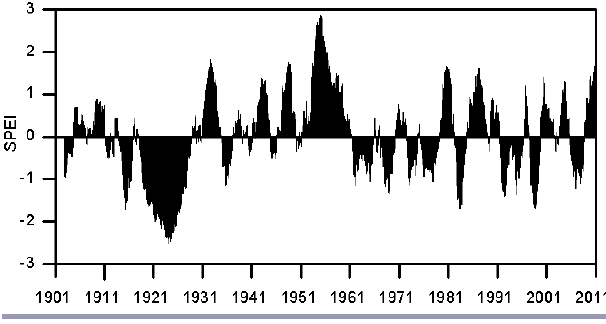
Fig. 3 . SPEI index (standardized precipitation evapotranspiration index), a multiscalar drought index, for a 24-month period, from 1901 to 2011 in the Bungku region. Categorization of dryness by SPEI: Near normal (-1 to 1); Moderate dryness (-1.49 to -1); Severe dryness (-1.99 to -1.5); Extreme dryness (less than -2). Same ranges for positive values indicate